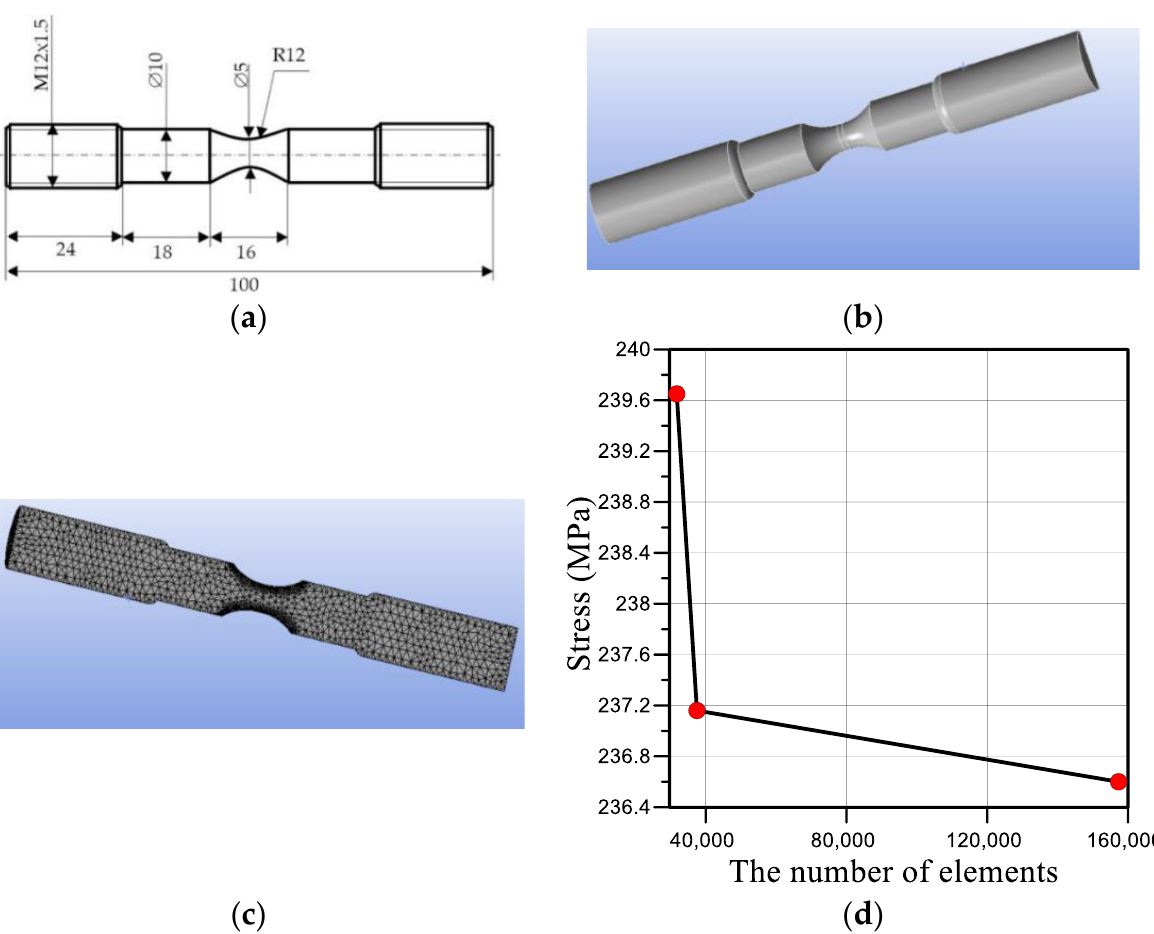
Figure 2. Schematic illustration of the geometry ( а ), the sample view ( b ), the sample breakdown into finite elements ( c ), and the mesh convergence study ( d ).